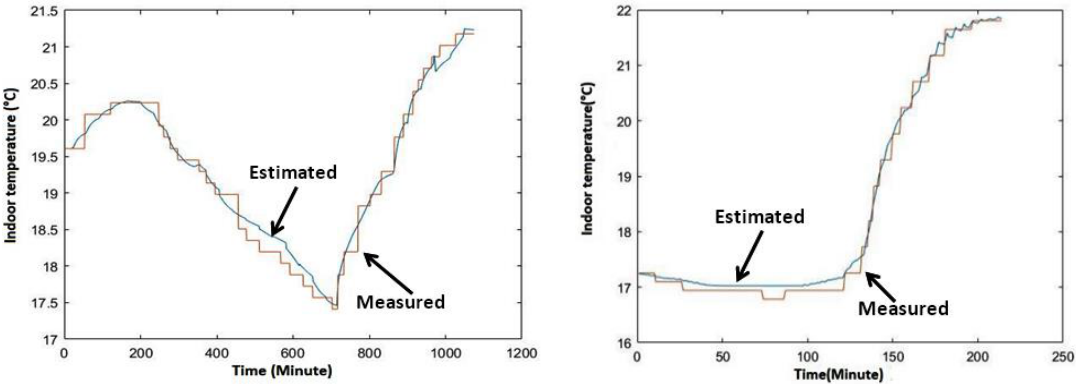
Figure 7. Model-based, multi-step predicted indoor temperature time history when the living space is empty (left-side) and when it is fully occupied (right-side).